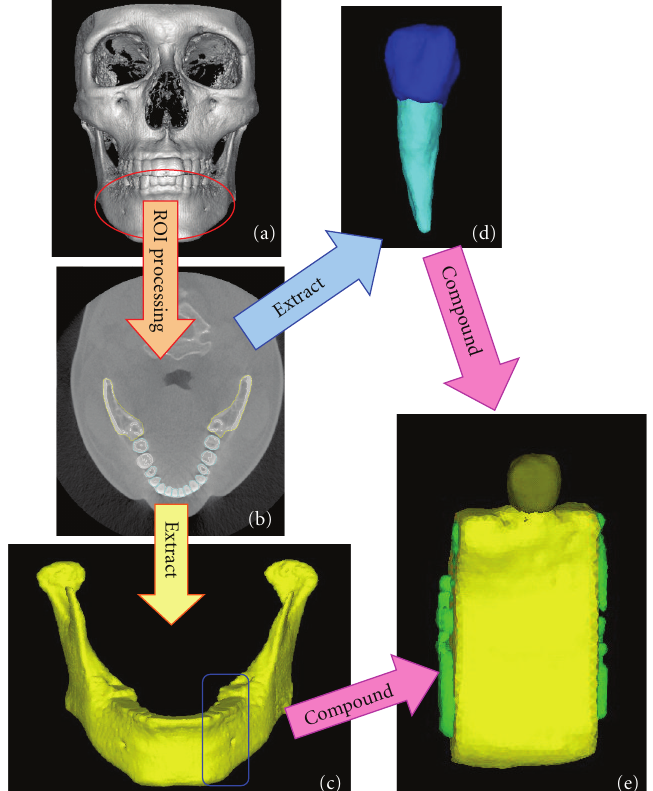
Figure 1: Flow of procedure for the FE modeling of the mandibular bone and tooth by MF. (a) CT scan of the testee, (b) extracting bone lines, (c) mandibular bone, (d) tooth, (e) 3D FE models.